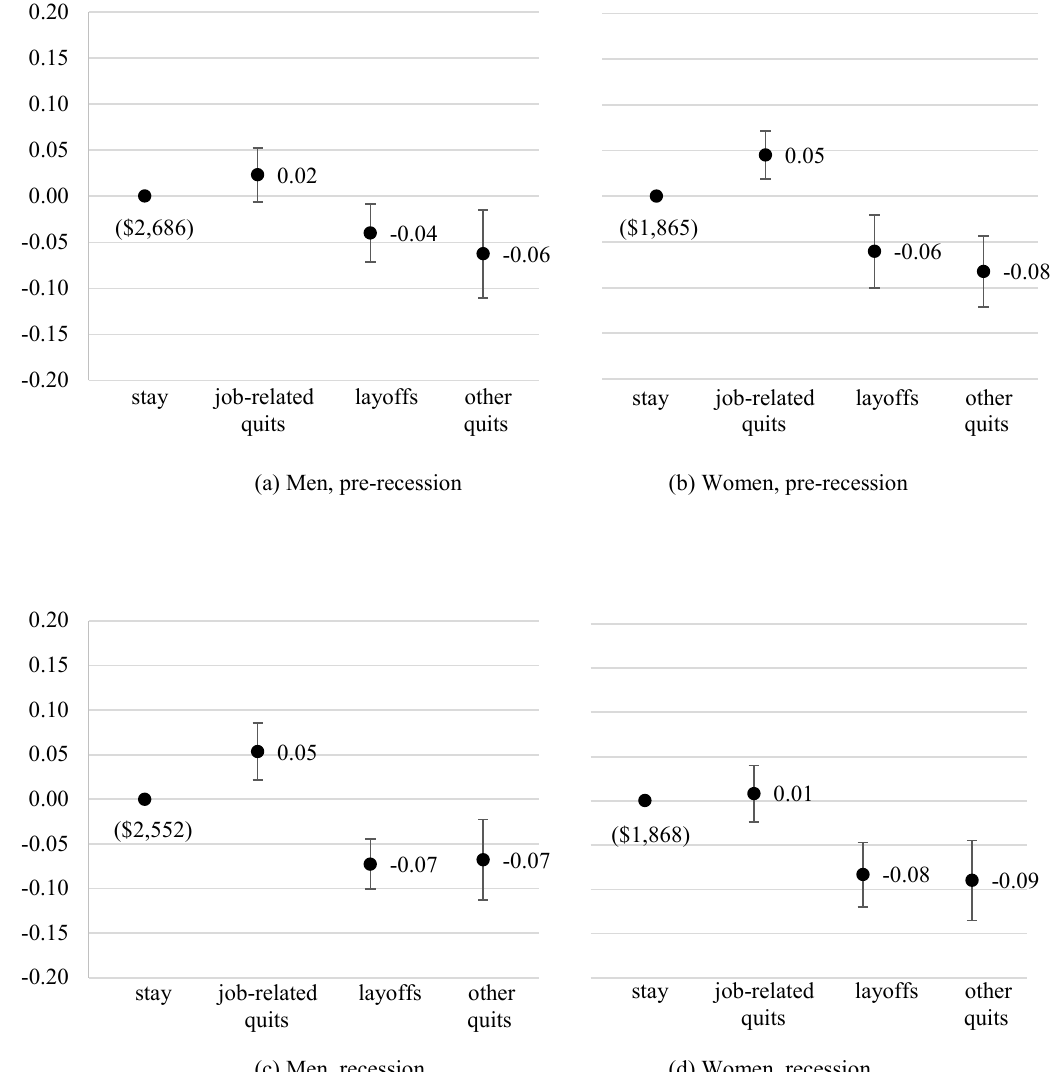
Figure 2. Differences in logged monthly earnings between childless stayers and job changers